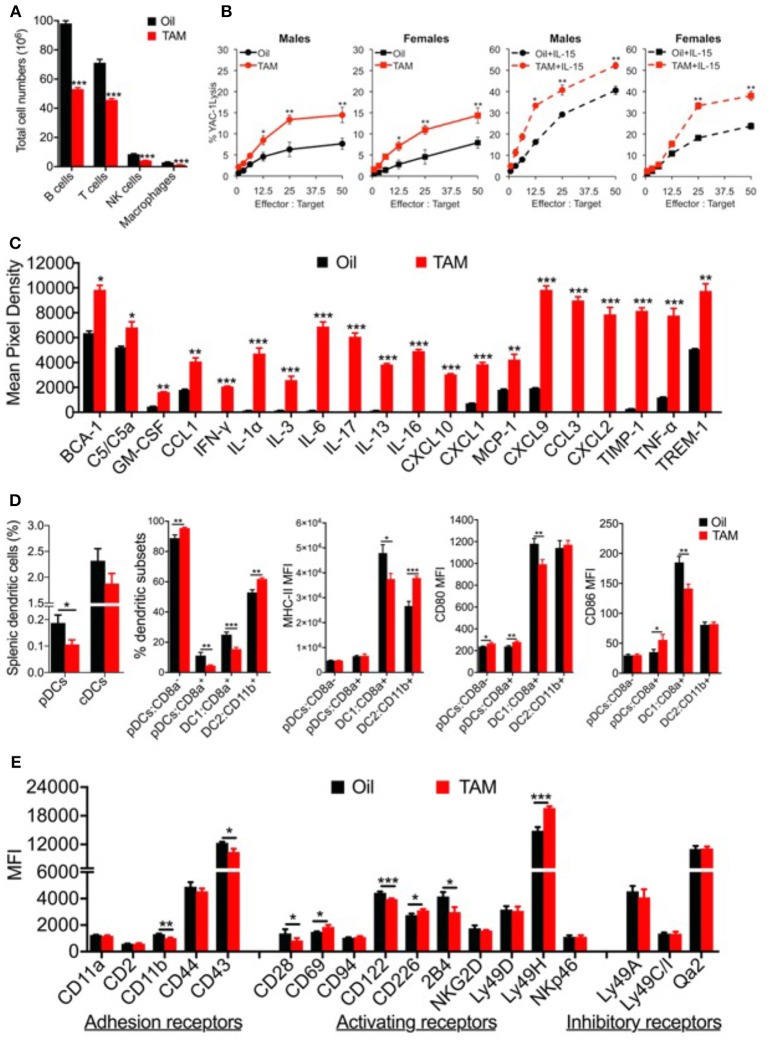
Clec16a knockout mice depicts altered immune cell populations, increased splenic NK cell cytotoxicity, upregulated cytokine and chemokine secretion and an imbalance in dendritic cell subsets with altered receptor expression. (A) Reduced spleen cell numbers and altered splenic Immune cell population in Clec16a KO (TAM) mice (n = 12 mice per group). *P < 0.05, **P < 0.01, ***P < 0.001 (unpaired two-tailed Student's t-test). (B) Cytotoxicity of resting and mrIL-15 (100 ng/ml) activated male and female murine splenocytes against 51Cr-labeled YAC-1 targets. Results show mean ± SE of three independent repeats. *P < 0.05, **P < 0.01, ***P < 0.001 (unpaired two-tailed Student's t-test). (C) The representative graph is quantification of cytokines and chemokine from plasma of Control (Oil) and Clec16a KO (TAM) mice using the Mouse Cytokine Array panel. Data represents means ± SE of three independent experiments. *P < 0.05, **P < 0.01, ***P < 0.001 (unpaired two-tailed Student's t-test). (D) Percent splenic dendritic cells (pDCs and cDCs), percent DC subsets, MHC-II, CD80, and CD86 MFI on pDCs, cDCs, and subsets from Clec16a KO and control mice analyzed by flow cytometry (n = 10 mice per group). Data represents means ± SE of three independent experiments. *P < 0.05, **P < 0.01, ***P < 0.001 (unpaired two-tailed Student's t-test). (E) MFI quantification graph depicting adhesion, activating and inhibitory receptors expressed on NK cells of control and Clec16a KO mice. Data represents means ± SE of three independent experiments (n = 12 mice per group). *P < 0.05, **P < 0.01, ***P < 0.001 (unpaired two-tailed Student's t-test).